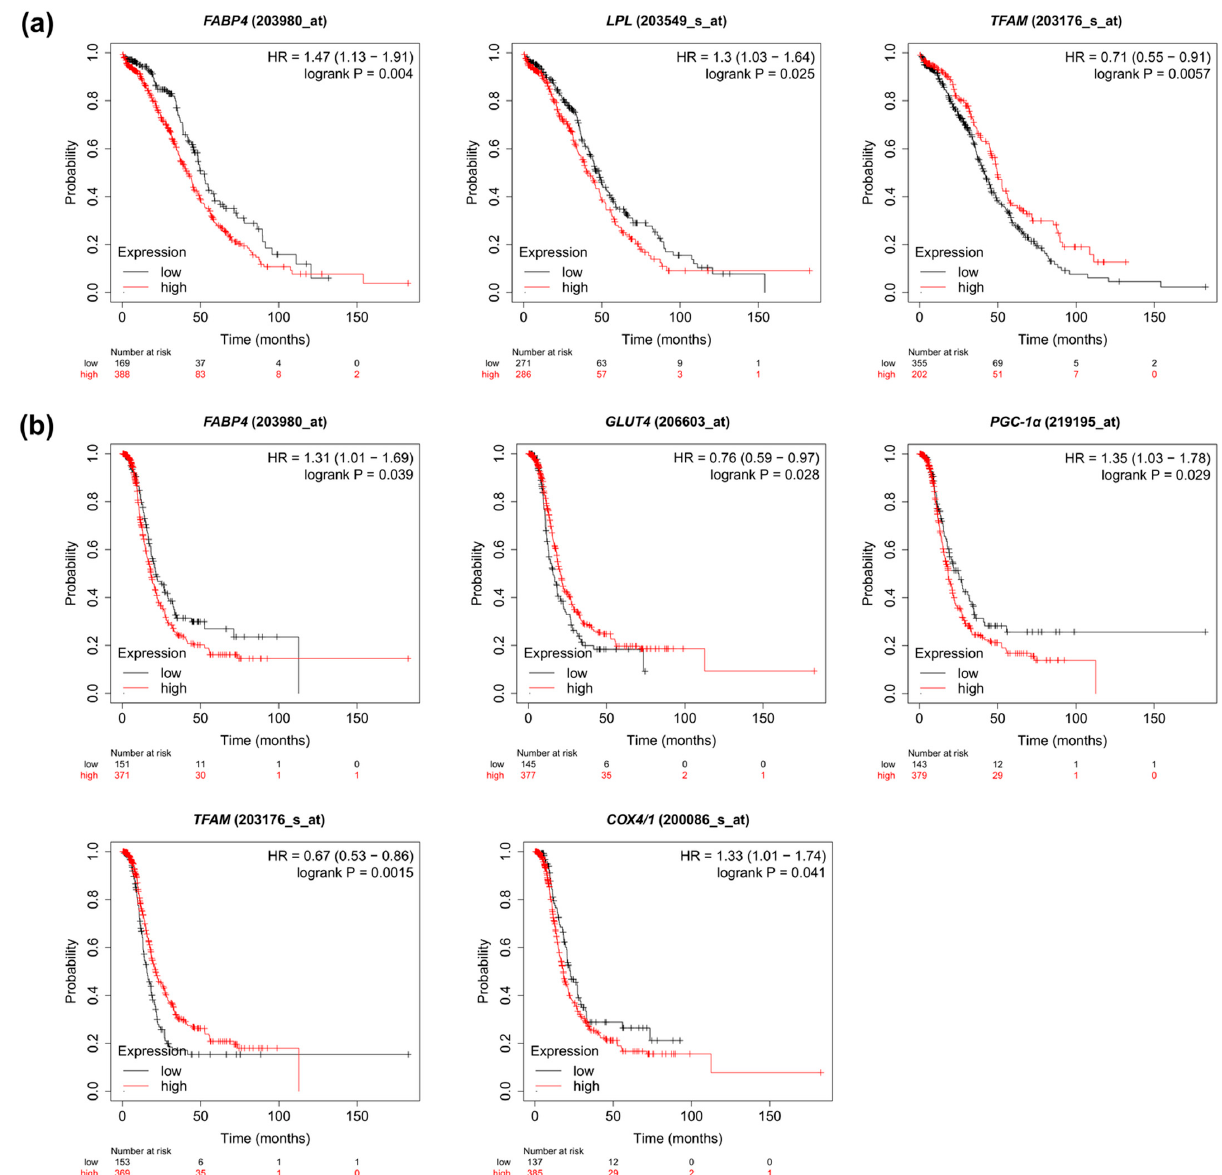
Figure 5. Kaplan–Meier curve analysis of ( a ) overall and ( b ) progression-free survival comparing high and low levels of the metabolism-associated genes.